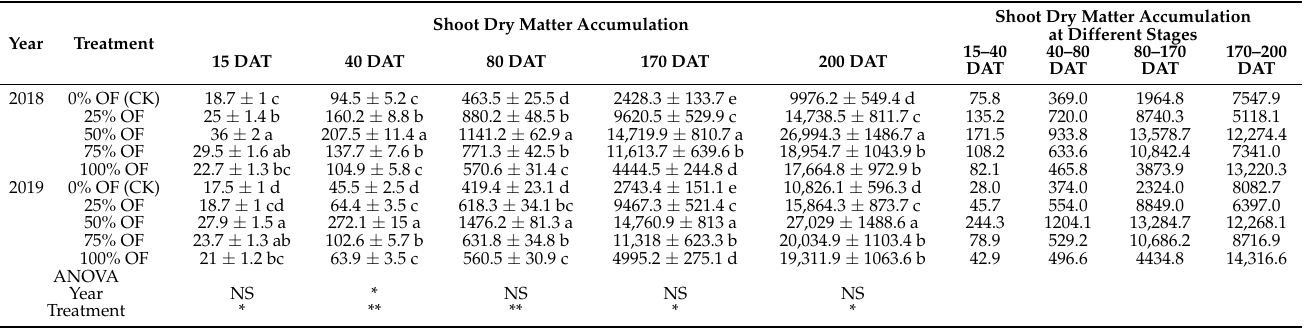
Table 3. Shoot dry matter accumulation and distribution at green seed harvest for different treatments.